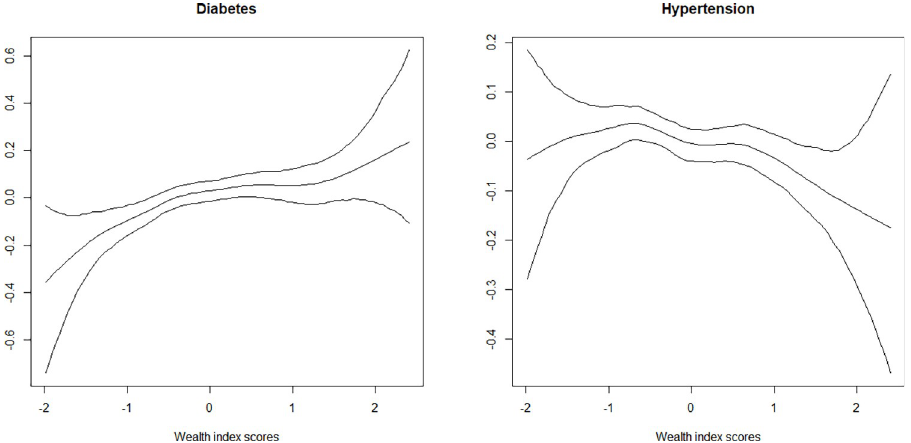
Fig 3. Non-linear effects of wealth index score on the log-odds of diabetes and hypertension (posterior means with the 97.5% credible interval are shown).